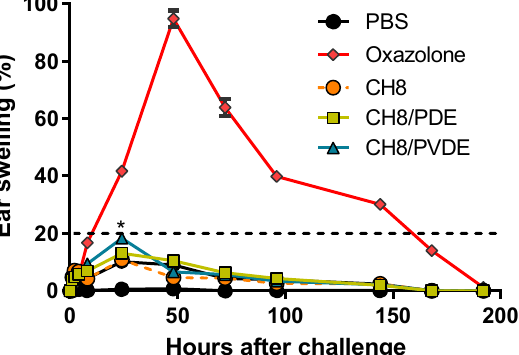
Figure 2. The mouse ear swelling test (MEST) following ear injection. Mice were given three s.c. injections in the rump with 10 μL of PBS or 30 μg of free CH8, CH8/PDE and CH8/PVDE on days −9, −7 and −5, and then challenged on day 0 with a homologous injection in the ear pinnae. Oxazo- lone (positive controls) was topically applied in the same sites (100%, 0.25 mm). Ear swelling was measured at the indicated times with a micrometer. The dotted line represents 20% of maximum oxazolone response. * p < 0.05 compared with PBS. Means ± SEM ( n = 5). For histopathology and biodegradation, a single s.c. injection with CH8 or MPs was given in the ear pinnae, and these were processed after 2 and 30 days. Figure 3 shows that after 2 days, abundant CH8/PDE and CH8/PVDE were visible at the injection site (arrow- heads), as well as some inflammatory infiltrates (arrows), compatible with Figure 2. After 30 days, the MPs were unseen (biodegraded), inflammatory infiltrates had disappeared, and ear sizes had returned to normal.